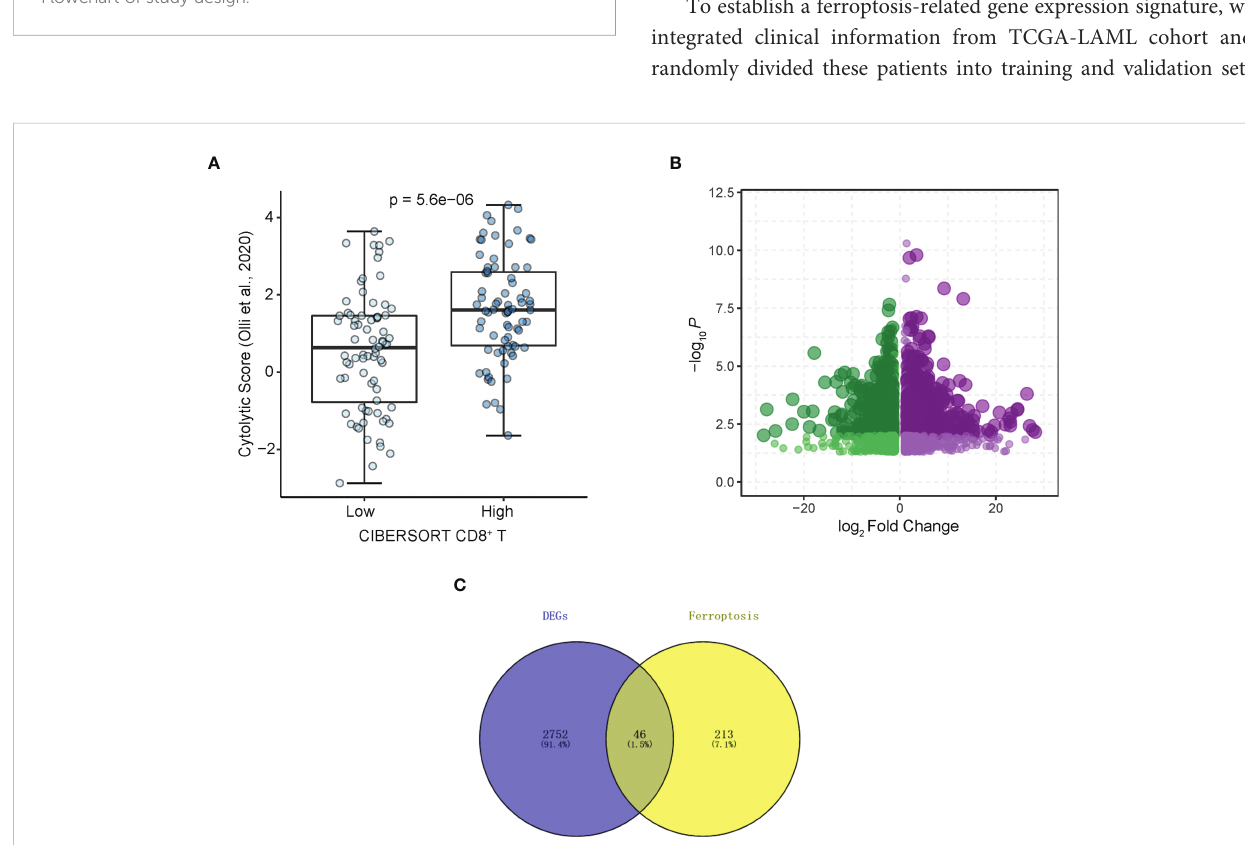
FIGURE 1 Flowchart of study